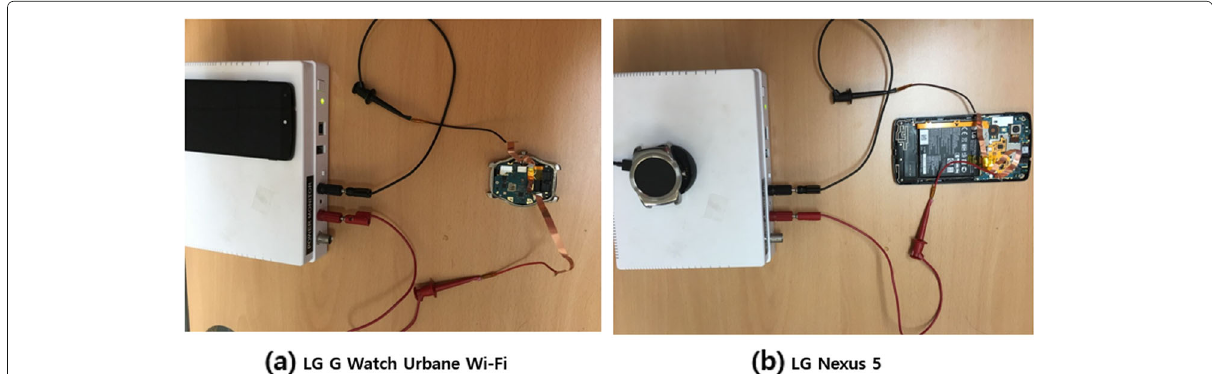
Fig. 3 Connection between the Monsoon Power Monitor and Smart